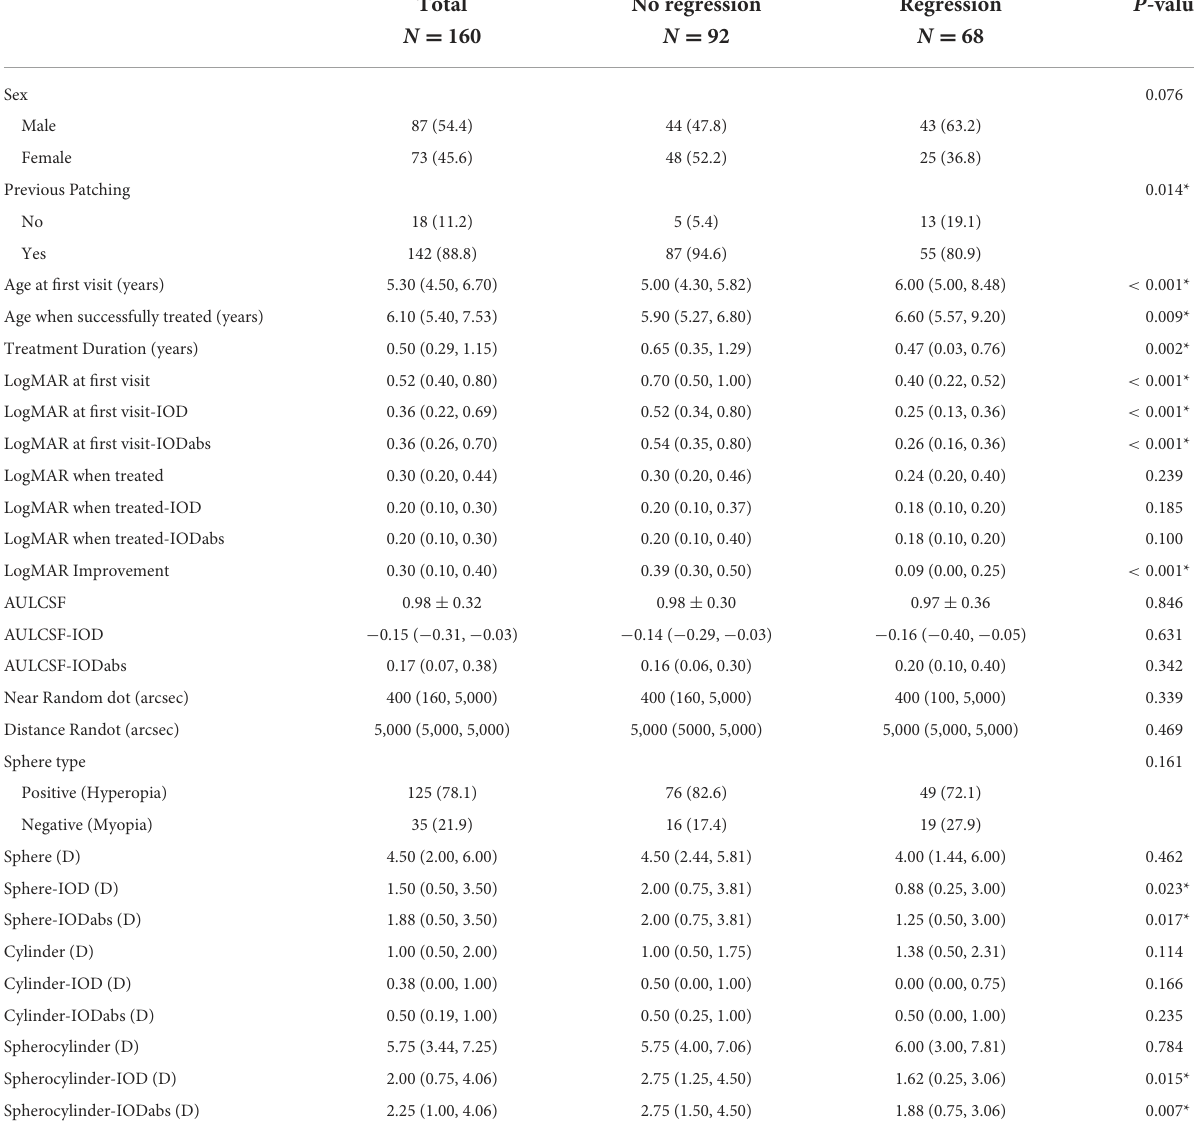
TABLE 1 Potential predictor variables included in the LASSO